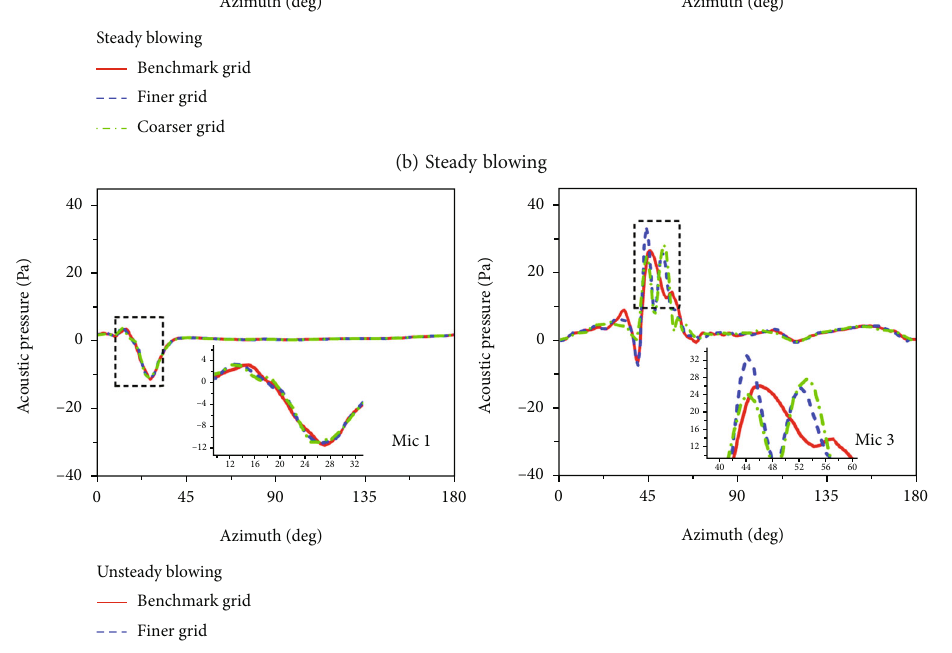
(c) Unsteady blowing